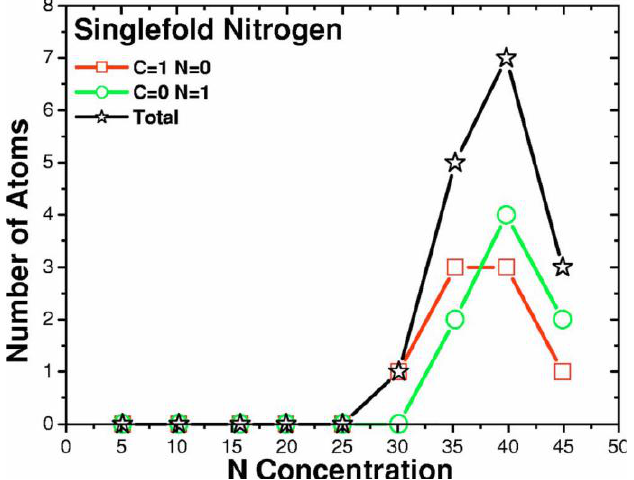
Figure 17. Single bonded nitrogens appear only at concentrations larger than 25%. There are nitrogens bonded to one carbon (squares) and to another nitrogen, molecular nitrogen